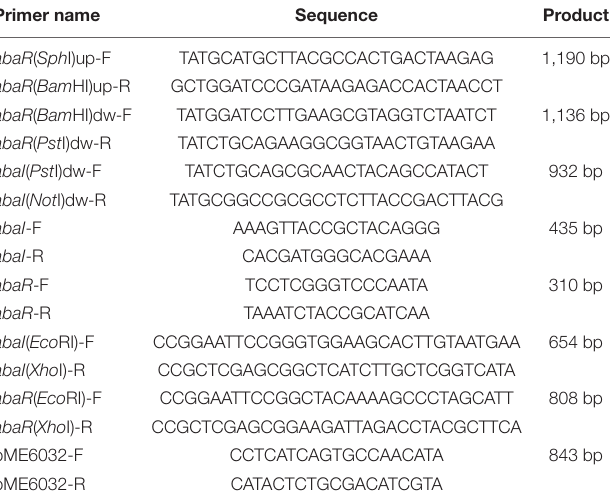
TABLE 2 | Primers used in this